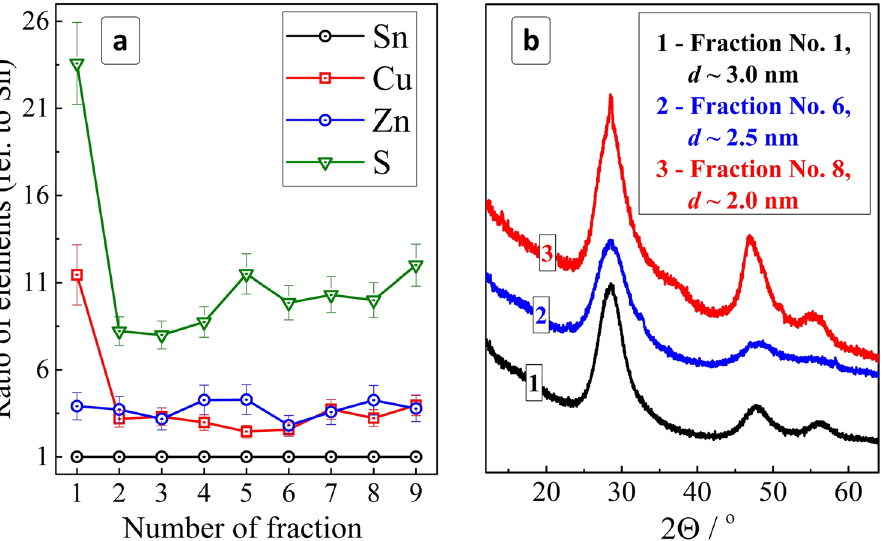
Figure 3. ( a ) Atomic ratios of elements (normalized to Sn) derived from the XPS data for different fractions of the size-selected CZTS NCs. ( b ) XRD patterns of CZTS NCs from fractions 2, 5, and 8 (initial metal ratio is Cu:Zn:Sn =